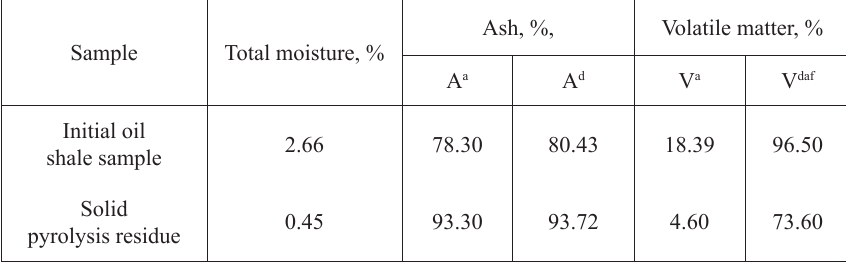
Table 3. Proximate analysis of oil shale and solid pyrolysis residue, wt% Ash, %, Volatile matter, Sample Total moisture, %